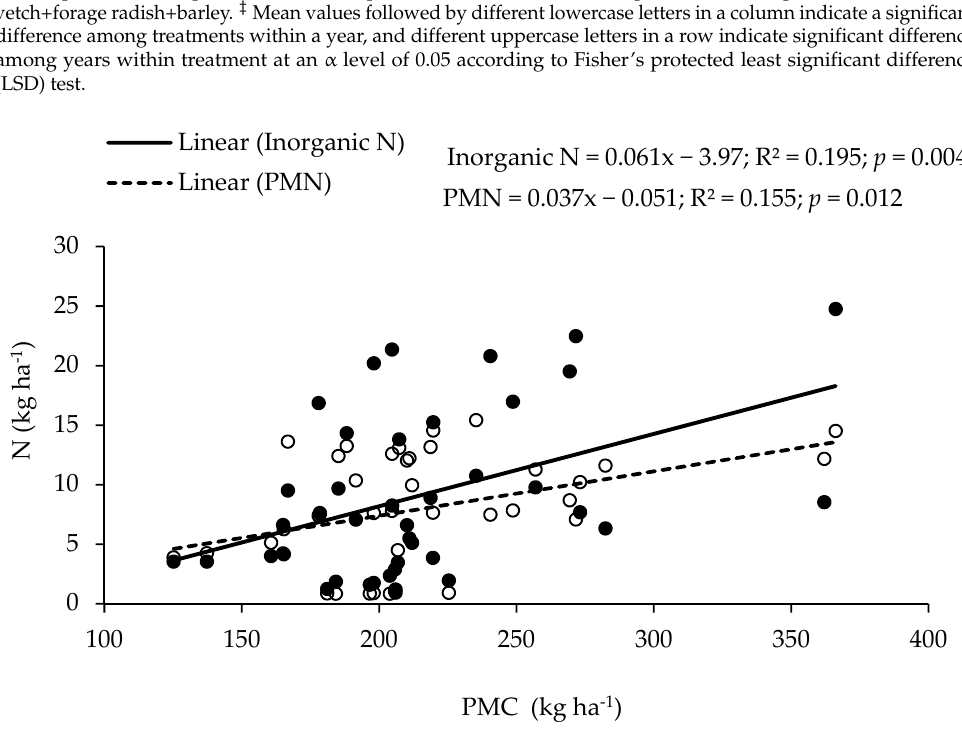
Figure 2. Simple linear regression between sorghum grain yield and potentially mineralizable nitrogen (PMN) ( n = 40) under various cover crop treatments in 2016–2020. 4. Discussion Soils with high SOC storage are often considered resilient because they can hold more water, resist erosion, and recycle nutrients. Diversifying cropping systems by integrating cover crops can improve soil resilience by increasing SOC accumulation and sustaining crop production. Our observation of higher PMC under SSM followed by oat and the low- est under pea across all study years suggests a continuous food supply (providing a C source) to microbes under diverse cover crop mixes, supporting higher microbial activity. The highest biomass produced by oat may have also increased SOC accrual. Our previous